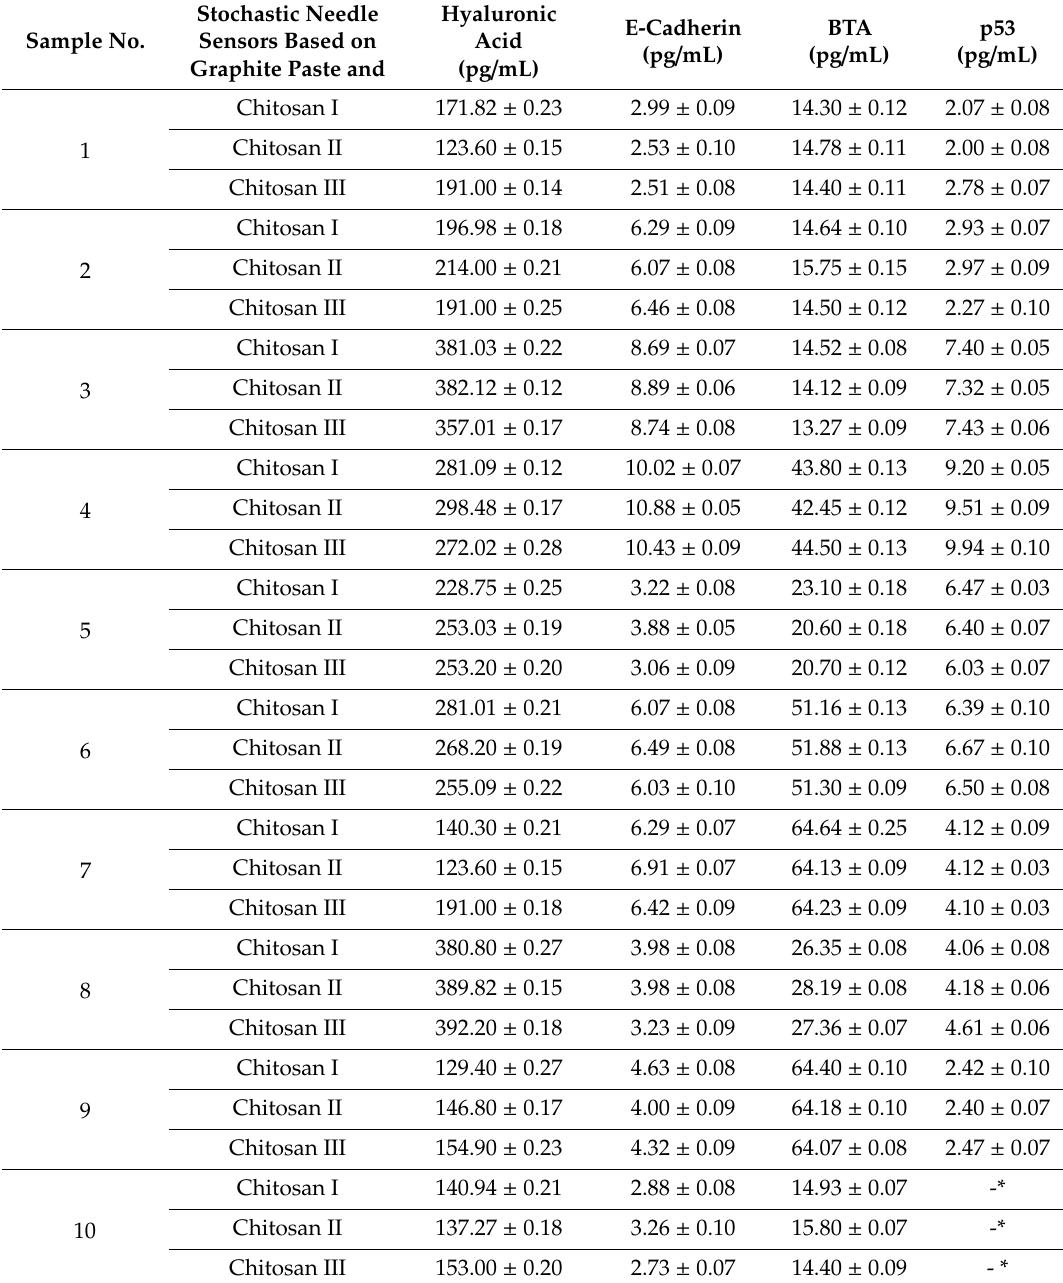
Table 3. The recovery of p-53, E-cadherin, BTA, and hyaluronic acid in whole blood samples using the stochastic needle sensors (N =